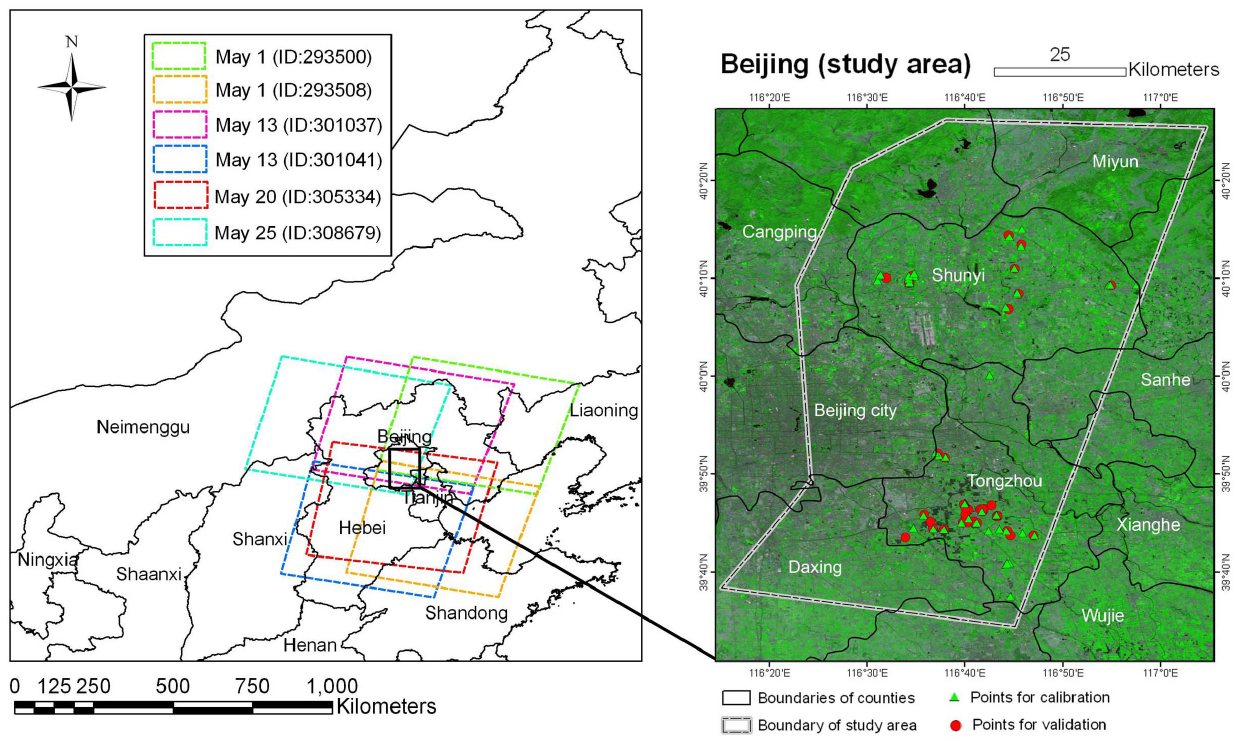
Figure 1. Location of survey points in the study area in Beijing, P. R. China. Left part displays the coverage of each HJ-CCD scene; right part illustrates the distribution of both training (green circle) and test survey points (red circle) in the study area. The imagery on the right side is displayed using a false color combination with R/G/B = Green/NIR/Red bands.